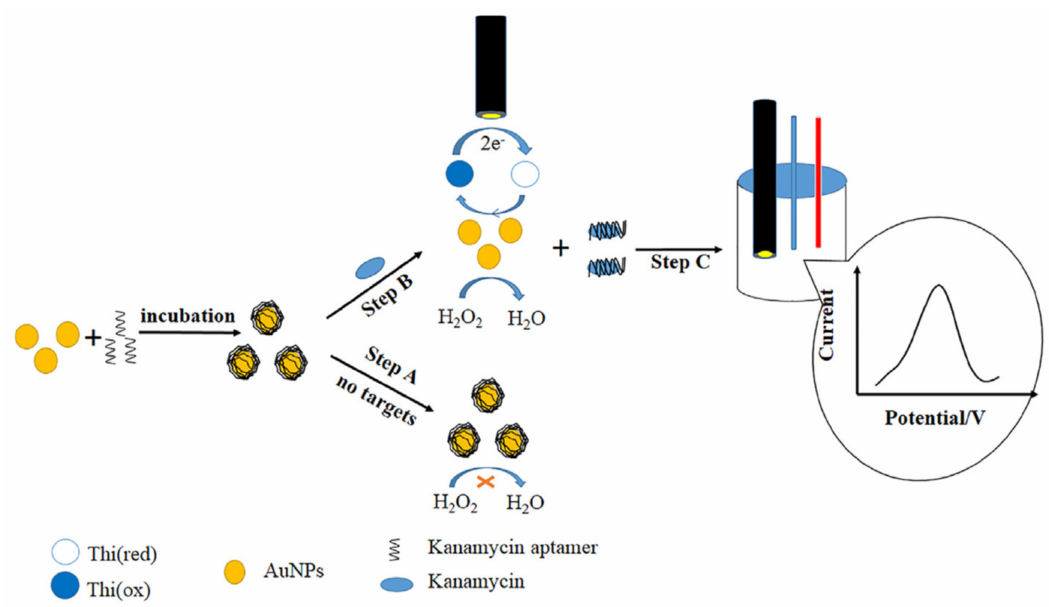
Figure 14. Schematic illustration of an electrochemical aptasensor for the detection of kanamycin in honey based on peroxidase-like activity of gold nanoparticles. Reprinted from reference [136] with permission from